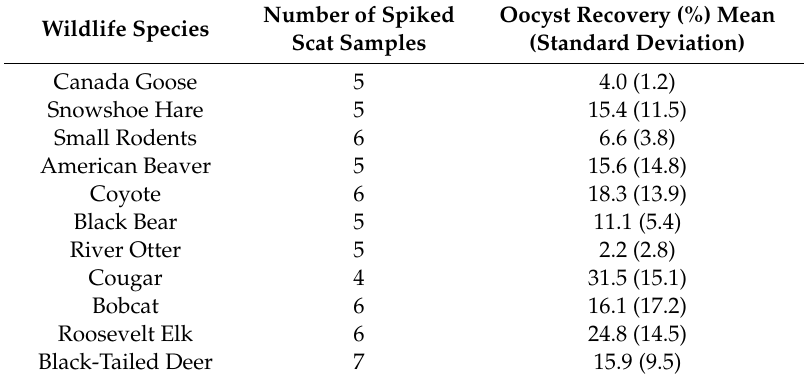
Table 1. Matrix spike recoveries for Cryptosporidium oocysts from scat samples of